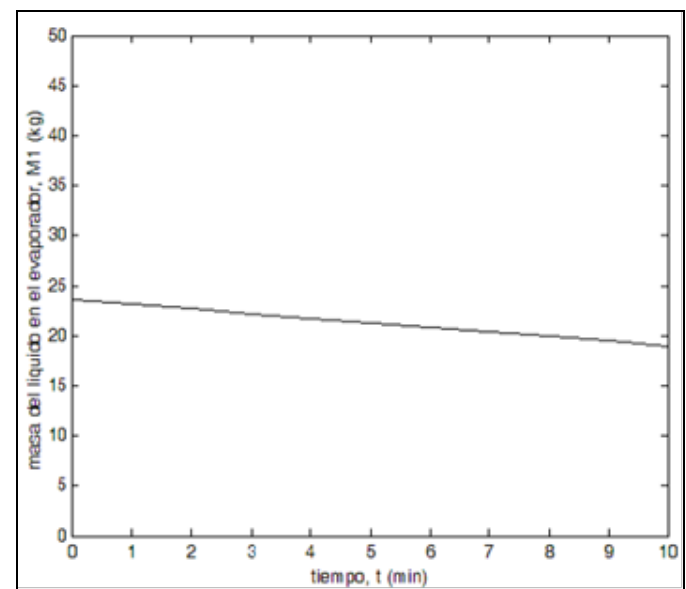
Figura 4: Gráfica masa de líquido en el evaporador contra tiempo de